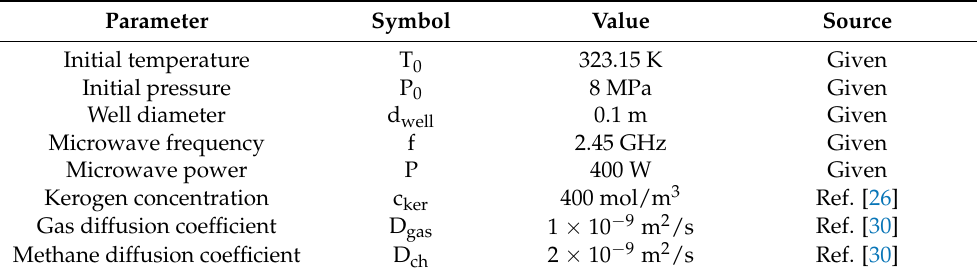
Table 2. Initial conditions and parameters of the proposed model.